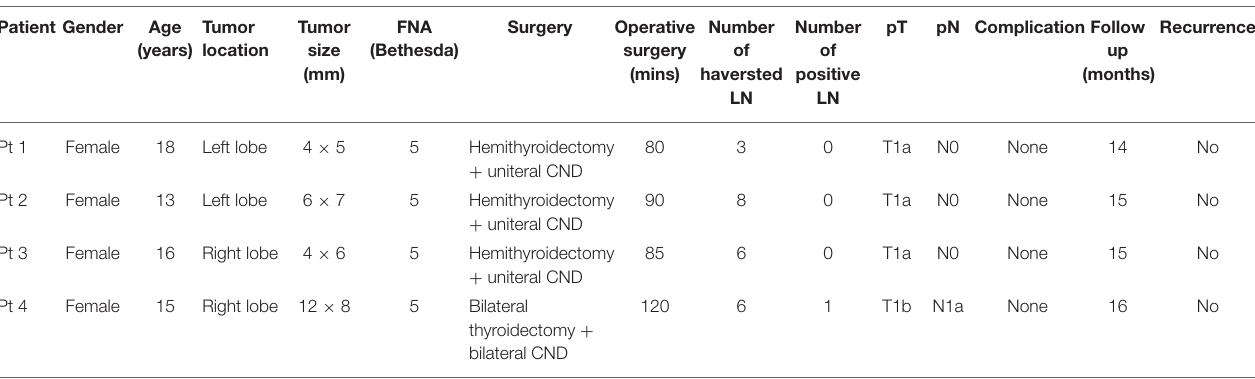
TABLE 1 | Individual case characteristics and surgical outcomes. Patient